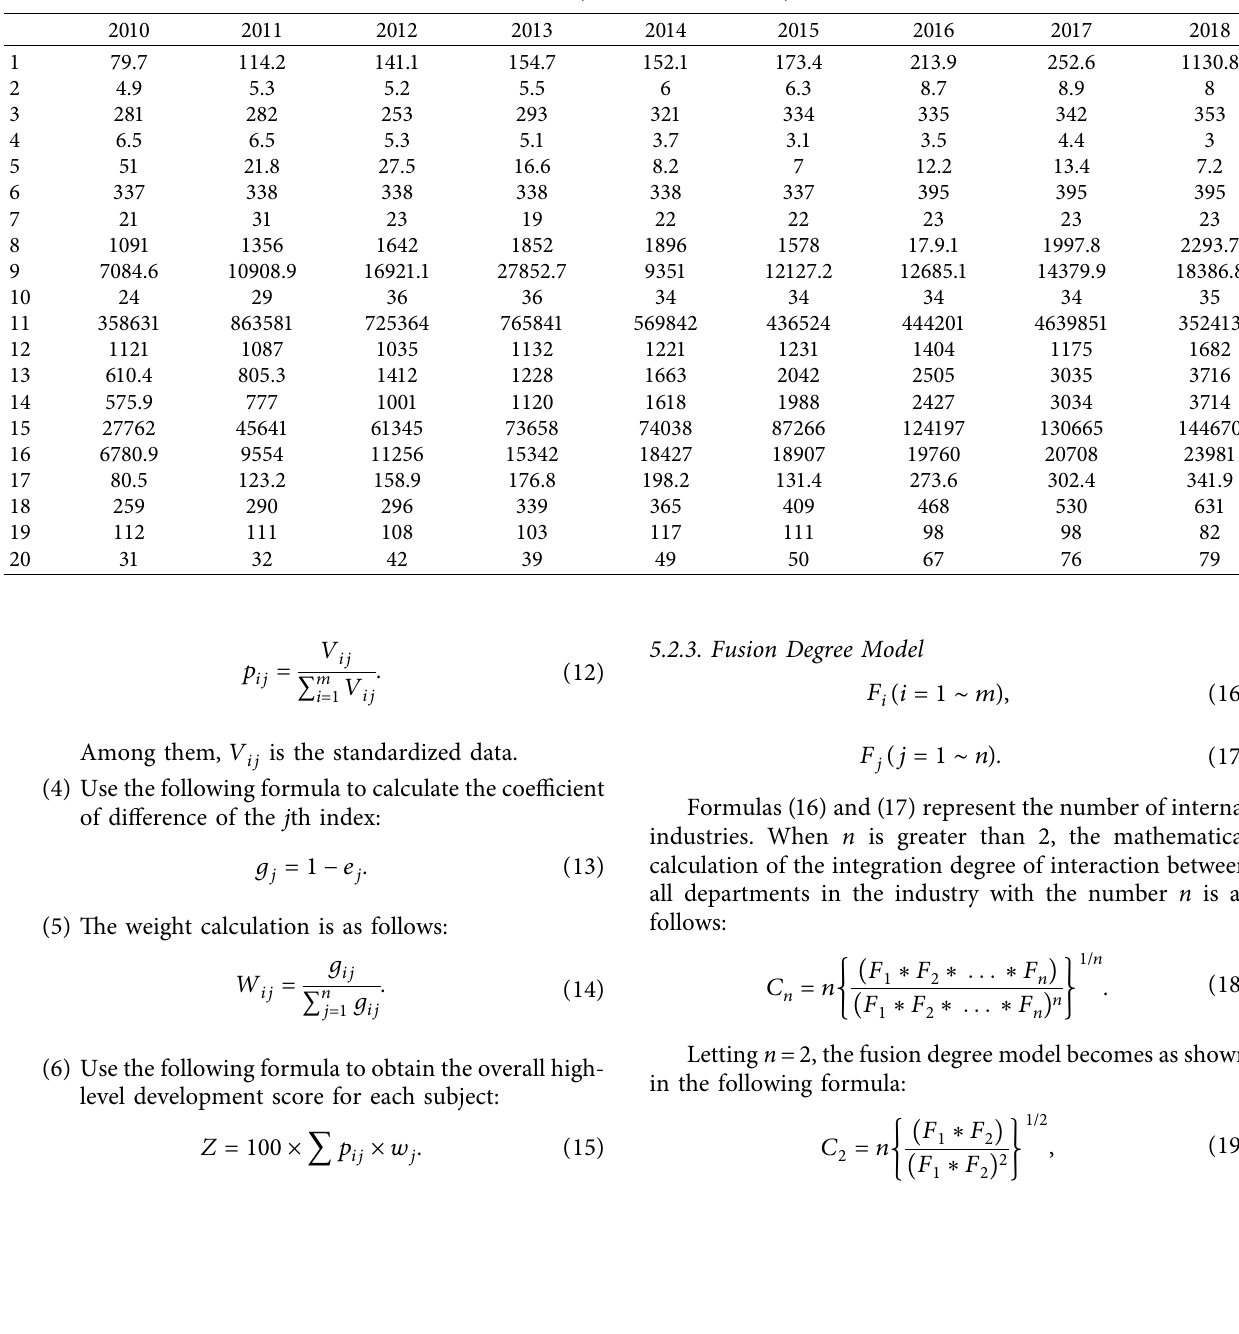
Table 4: Statistical table of cultural industry and tourism industry indicators from 2010 to